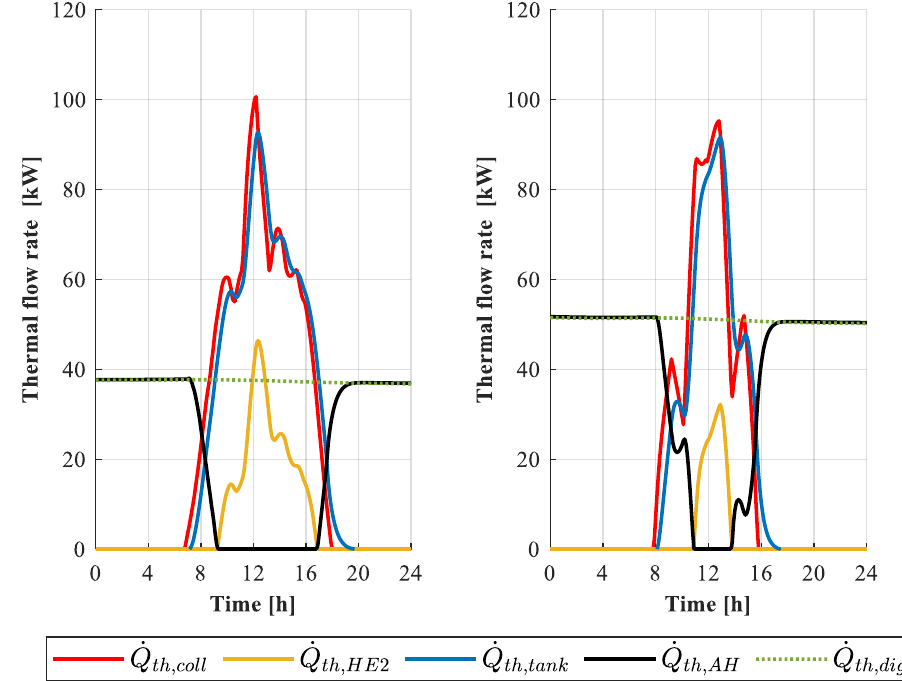
Figure 3. Dynamic results for thermal flow rates in typical summer ( left ) and winter ( right ) day .